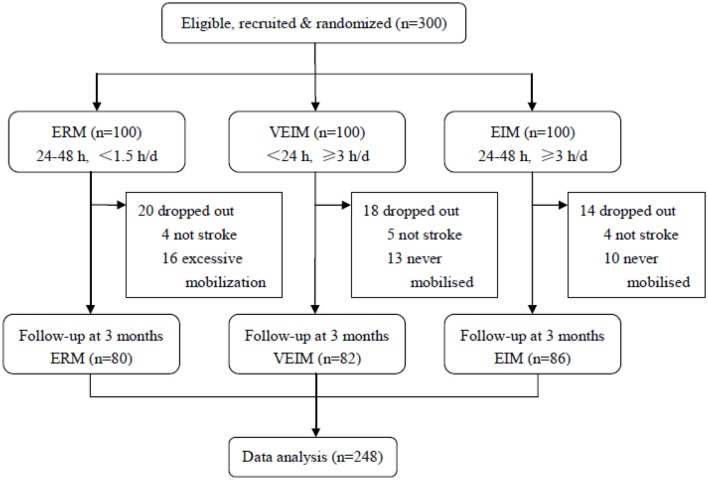
Trial profile. ERM, Early Routine Mobilization; VEIM, Very Early Intensive Mobilization; EIM, Early Intensive Mobilization. Three hundred patients were assigned randomly (1:1:1) to three groups. Two hundred and forty-eight (82.7%) patients finished the training and follow-up assessment, 80 in ERM, 82 in VEIM and 86 in EIM groups, while 52 patients (20 in ERM, 18 in VEIM, and 14 in EIM) dropped out for various reasons. In total, 80 in ERM, 86 patients in EIM and 82 patients in VEIM finished the training and the follow-up, and were thus analyzed.